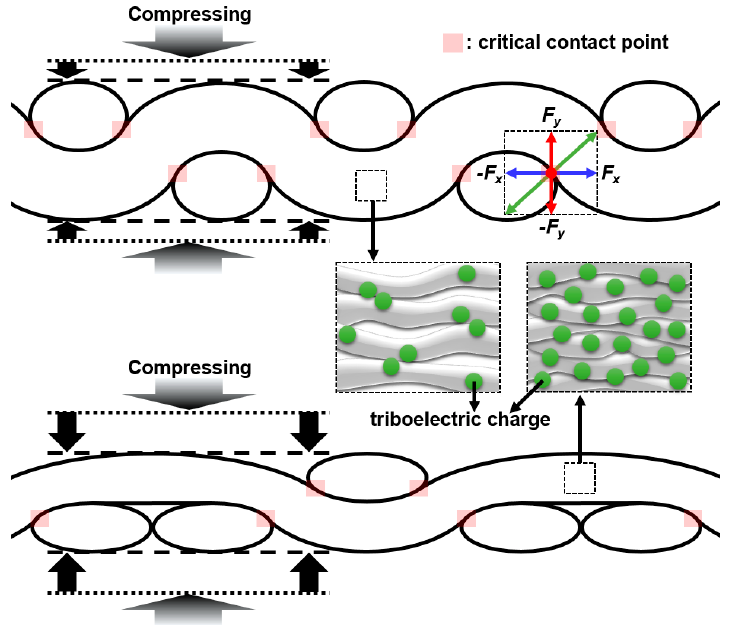
Figure 4. Schematics of plain- and 2 / 1 twill-woven cotton textiles to which compressive forces were applied.